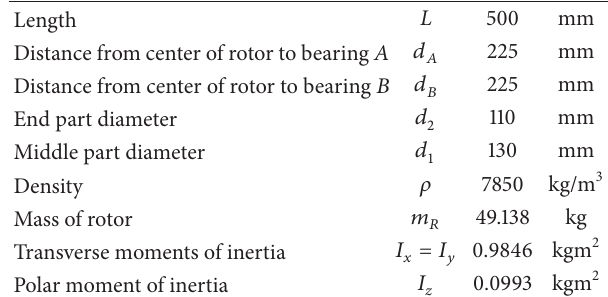
Table 2: Dimensions of the rigid